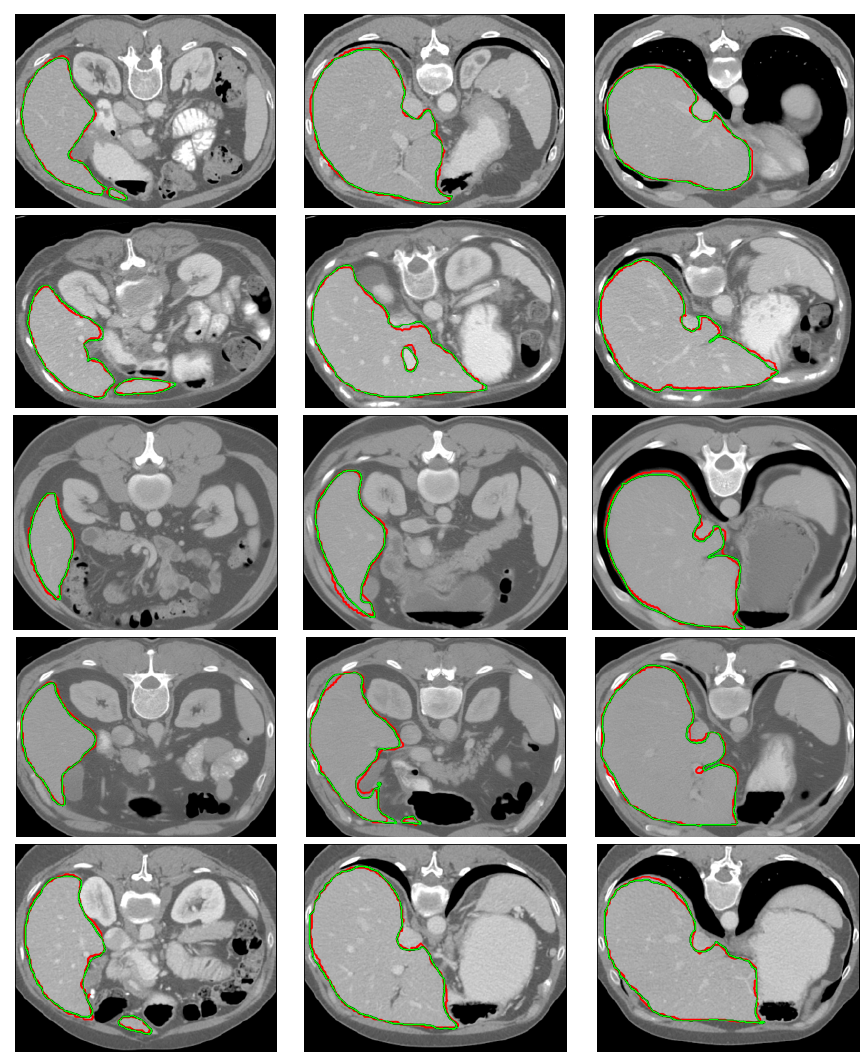
Figure 8. Examples of segmentation results from our method and ground truth of CT slices from the BTCV dataset and TCIA Pancreas-CT datasets. Each row is from the same patient, red is ground truth and green is the segmentation result obtained by our